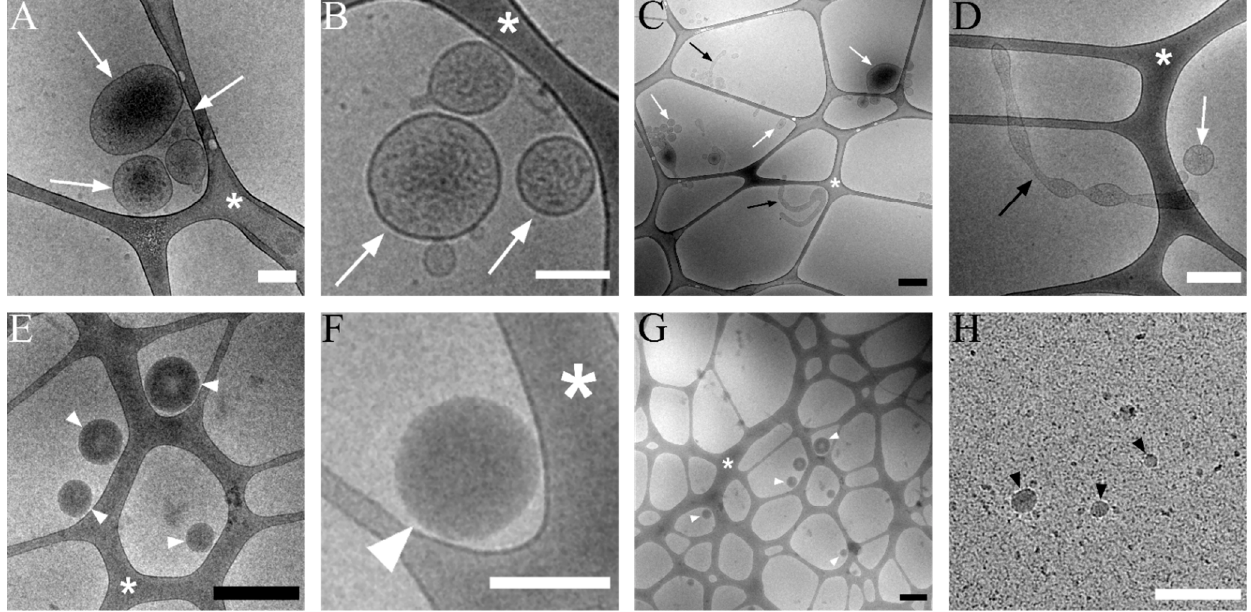
Figure 4. Cryo-TEM of isolated lEVs (upper row) and supernatant plasma deprived of lEVs (lower row). ( A , B ) A detailed picture of lEVs (white arrow). ( C ). Overview of lEVs sample. lEVs (white arrow), elongated vesicle (black arrow) ( D ). Elongated vesicles (black arrow) which occasionally present in isolated lEVs (white arrow). ( E ). Electron-dense vesicles commonly present in plasma supernatant after lEVs isolation (white arrowhead). ( F ). A detailed picture of the electron-dense vesicle (white arrowhead). ( G ). Plasma supernatant showing the electron-dense vesicles (white arrowheads) and impurities such as protein aggregates. ( H ). Small (up to 50 nm) vesicles (black arrowhead) and proteins are visible in the picture. White scale bar 200 nm, black scale bar 500 nm. Asterisk marks lacey carbon support film on the grid.